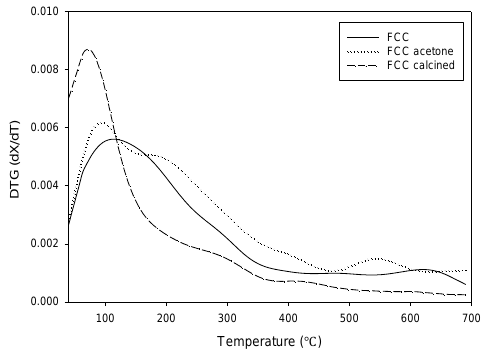
Figure 2. Derivative thermogravimetry (DTG) curves of catalysts. Table 1. Brunauer-Emmett-Teller (BET) surface area, pore size and pore volume of the catalysts. Fluidized catalytic cracking: FCC.